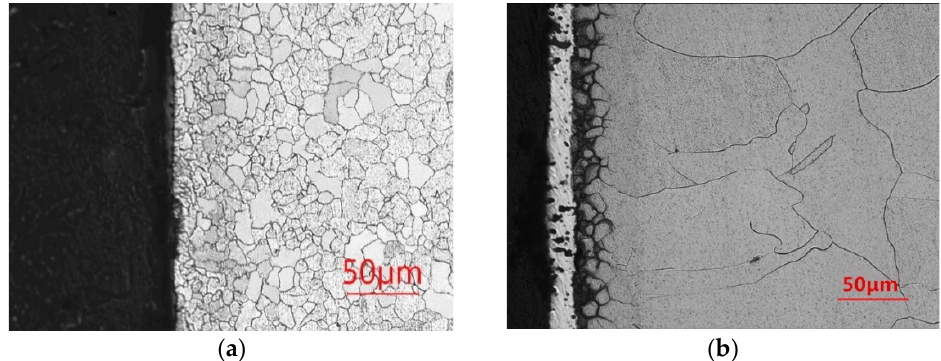
Figure 3. Comparison of microstructure before and after diffusion annealing at 1000 °C: ( a ) before annealing; ( b ) after annealing.